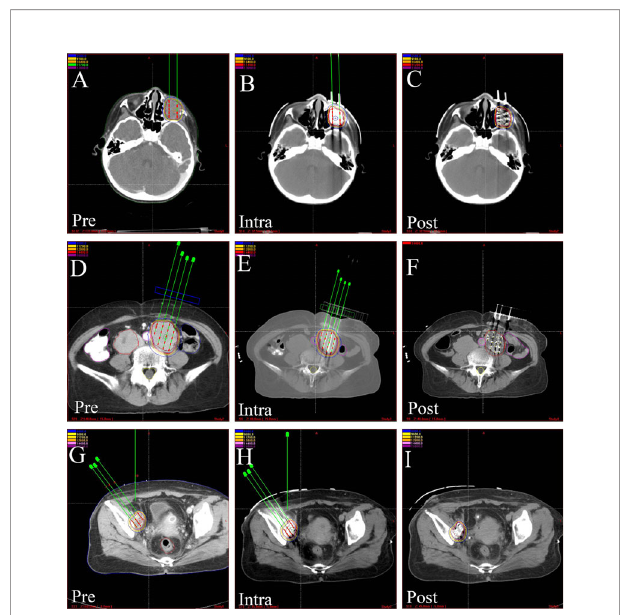
FIGURE 3 | The CT-scan images of treatment plan assisted by 3D-PCT. Preoperative treatment plan, intraoperative veri fi cation, and postoperative dosimetric evaluation in, (A – C) orbital rhabdomyosarcoma, (D – F) kidney cancer, (G – I) pelvic recurrence of cervical cancer. 3D-PCT, three-dimensional printing coplanar template.